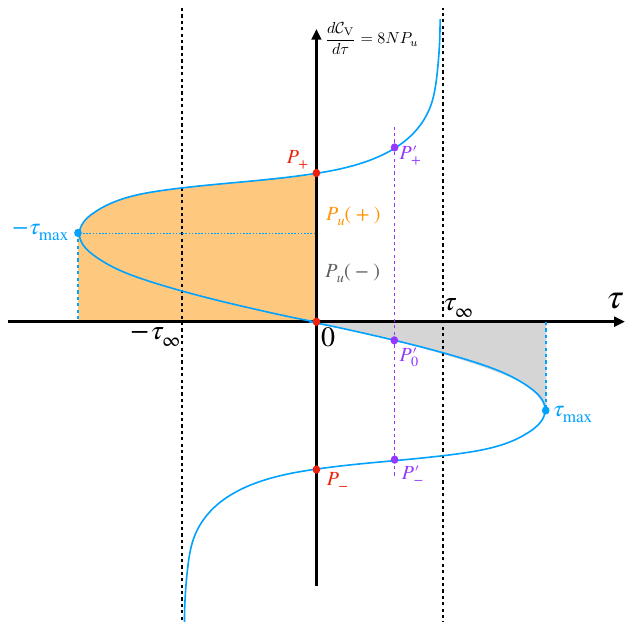
Figure 18 . Multiple extremal surfaces at a fixed boundary time τ